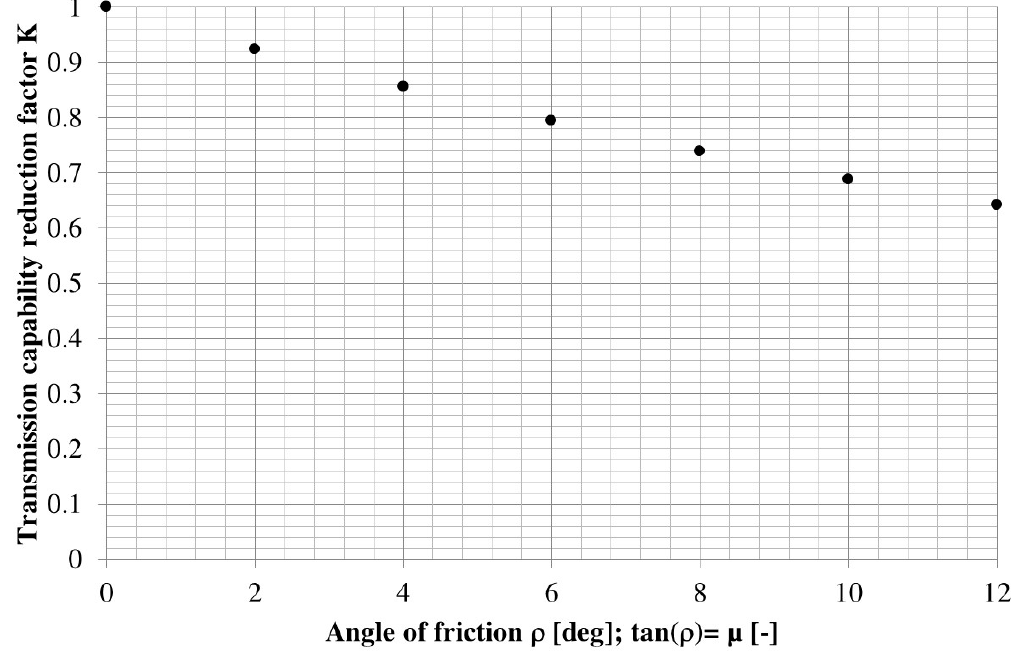
Figure 5. Reduction factor of transmission load K as a function of the angle of friction ρ . The pressure between the teeth is also affected by the coefficient of friction, but with a lower effect. By non-linear finite element analyses (non-linear due to sliding elements in contact), it is possible to calculate the percentage reduction factor for the tooth pressure (K p ) with respect to the value calculated by Equation (6)) and, then, to plot it in the diagram of Figure 6. In the case of negligible friction ( µ = 0) the difference between Equation (6) and the numerical investigation is almost equal to